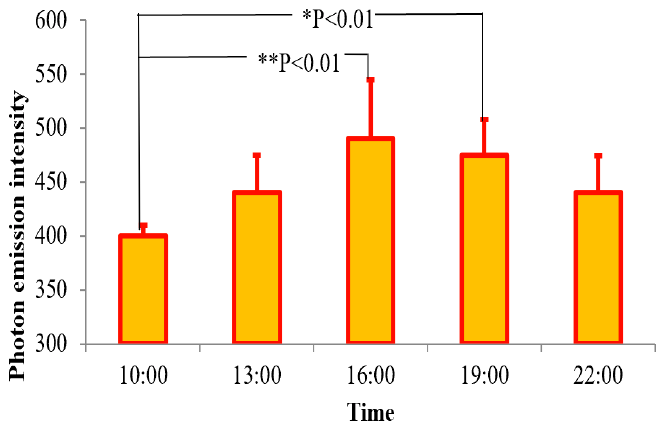
Figure 10. Daily rhythm of photon emission from 5 volunteers.